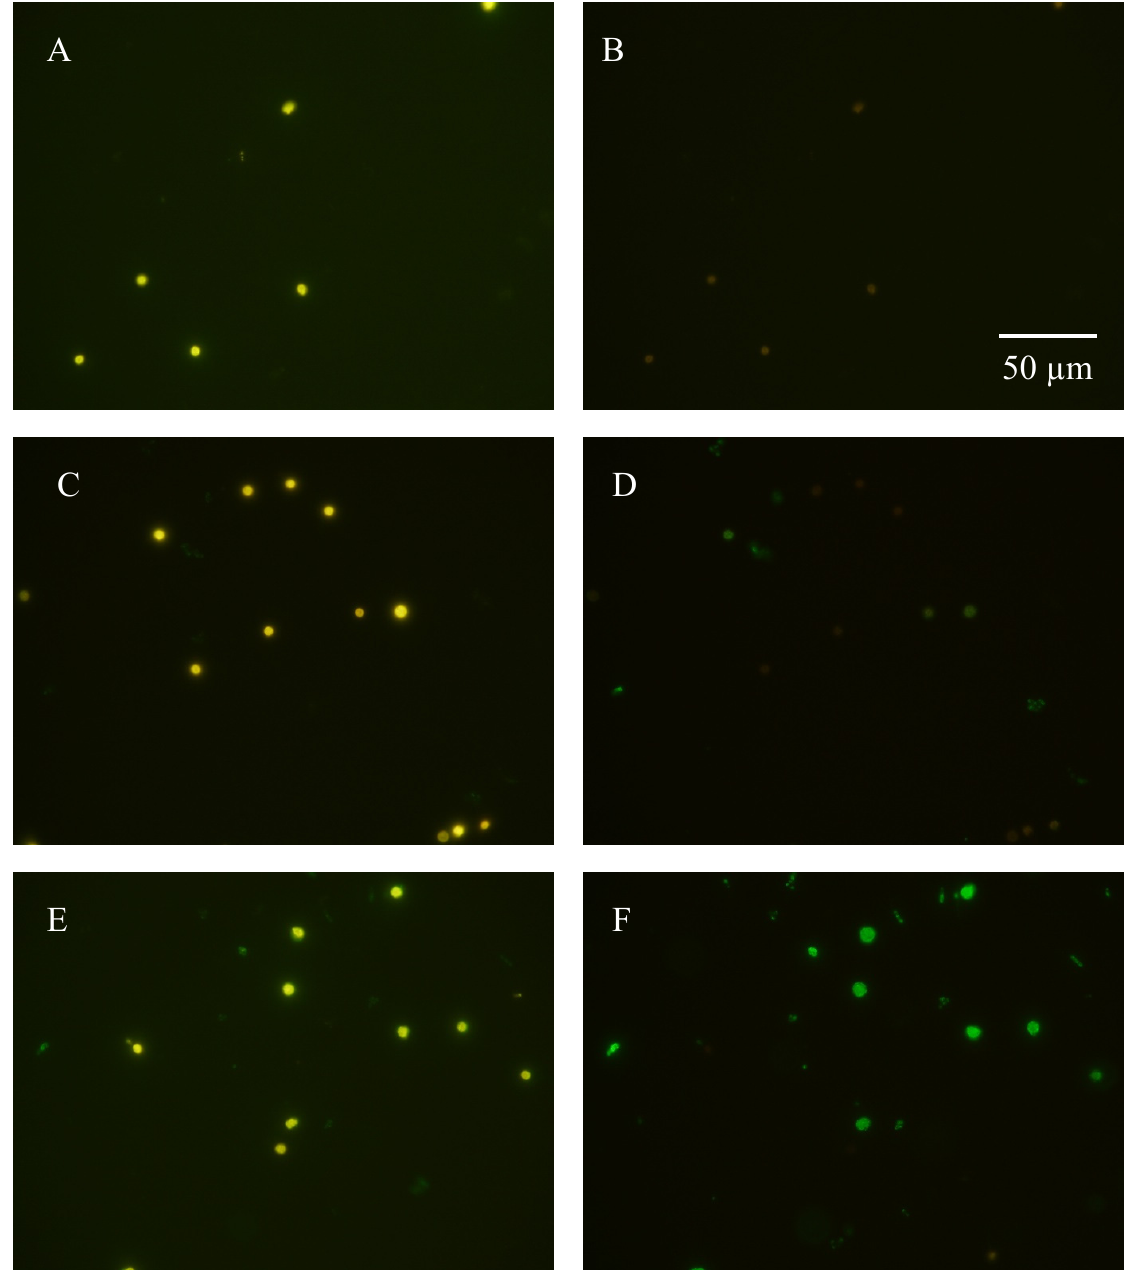
Figure 3. Immunodection of IdiA accumulation in C . watsonii cells. Binding of the IdiA antibody to cellular structures was visualized by subsequent incubation with the Qdot 525 anti-rabbit IgG antibody. Autofluorescent cells from iron deplete cultures where the primary anti-IdiA antibody was omitted prior to blue light photobleaching treatment (A). The same field after photobleaching with no Qdot 525 signal (B). Autofluorescent cells from iron replete cultures prior to photobleaching treatment (C). The same field after photobleaching with minimal Qdot 525 labeling (D). Autofluorescent cells from iron depleted cultures prior to photobleaching treatment (E). The same field after photobleaching exhibiting strong Qdot 525 labeling of the cells (F). All images captured at 1000X